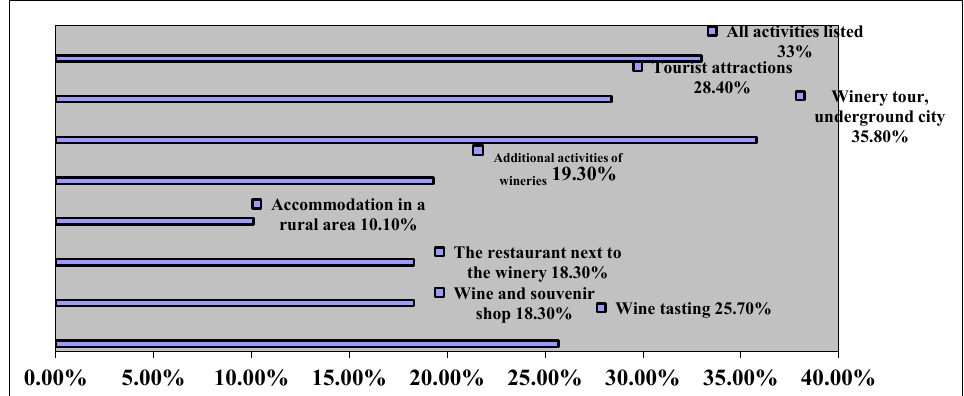
Figure 5. The composition of the tourist product of the wineries.